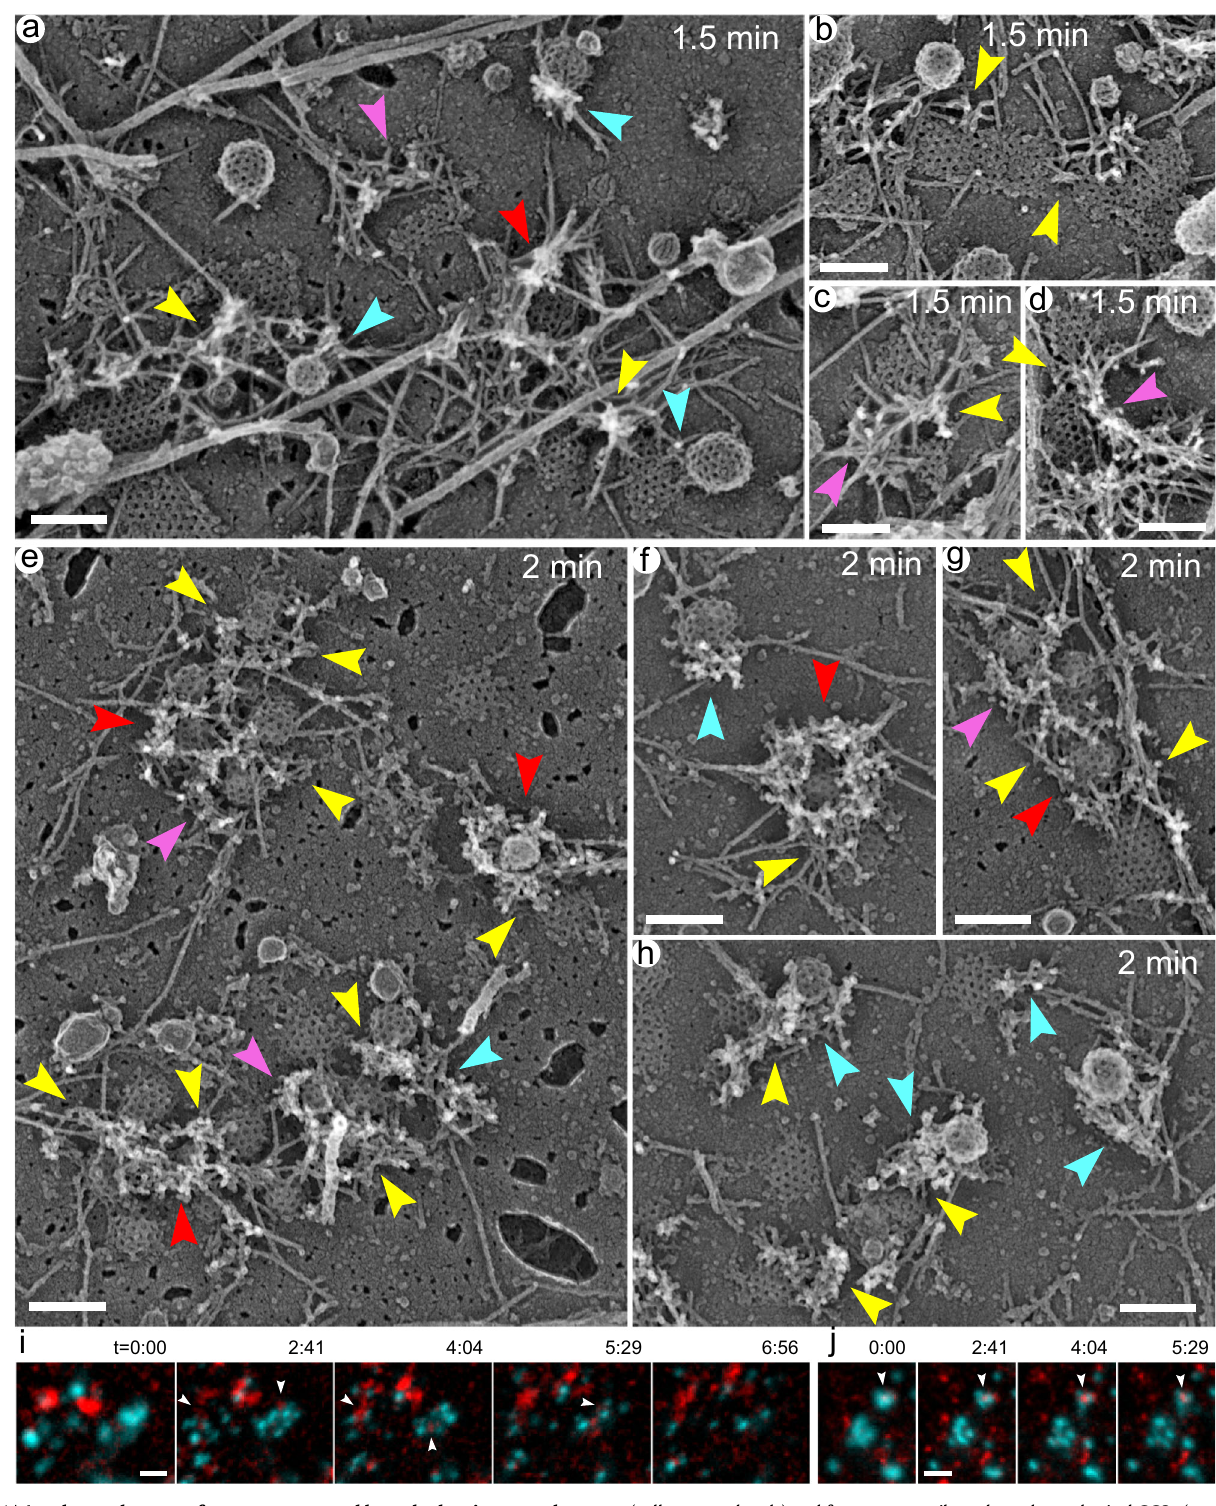
(yellow arrowheads) and form comet tails at domed or spherical CCSs (cyan arrowheads). i , j Still frames from TIRF microscopy time-lapse sequences of PtK2 cellsexpressingGFP-CLC(cyan)andmCherry-cortactin(red)takeninthepresence of CK-666 (t=0:00) and following CK-666 washout; time after washout for indi- vidual frames is shown as min:sec. Scale bars, 200nm ( a – h ) and 2 μ m ( i , j ).